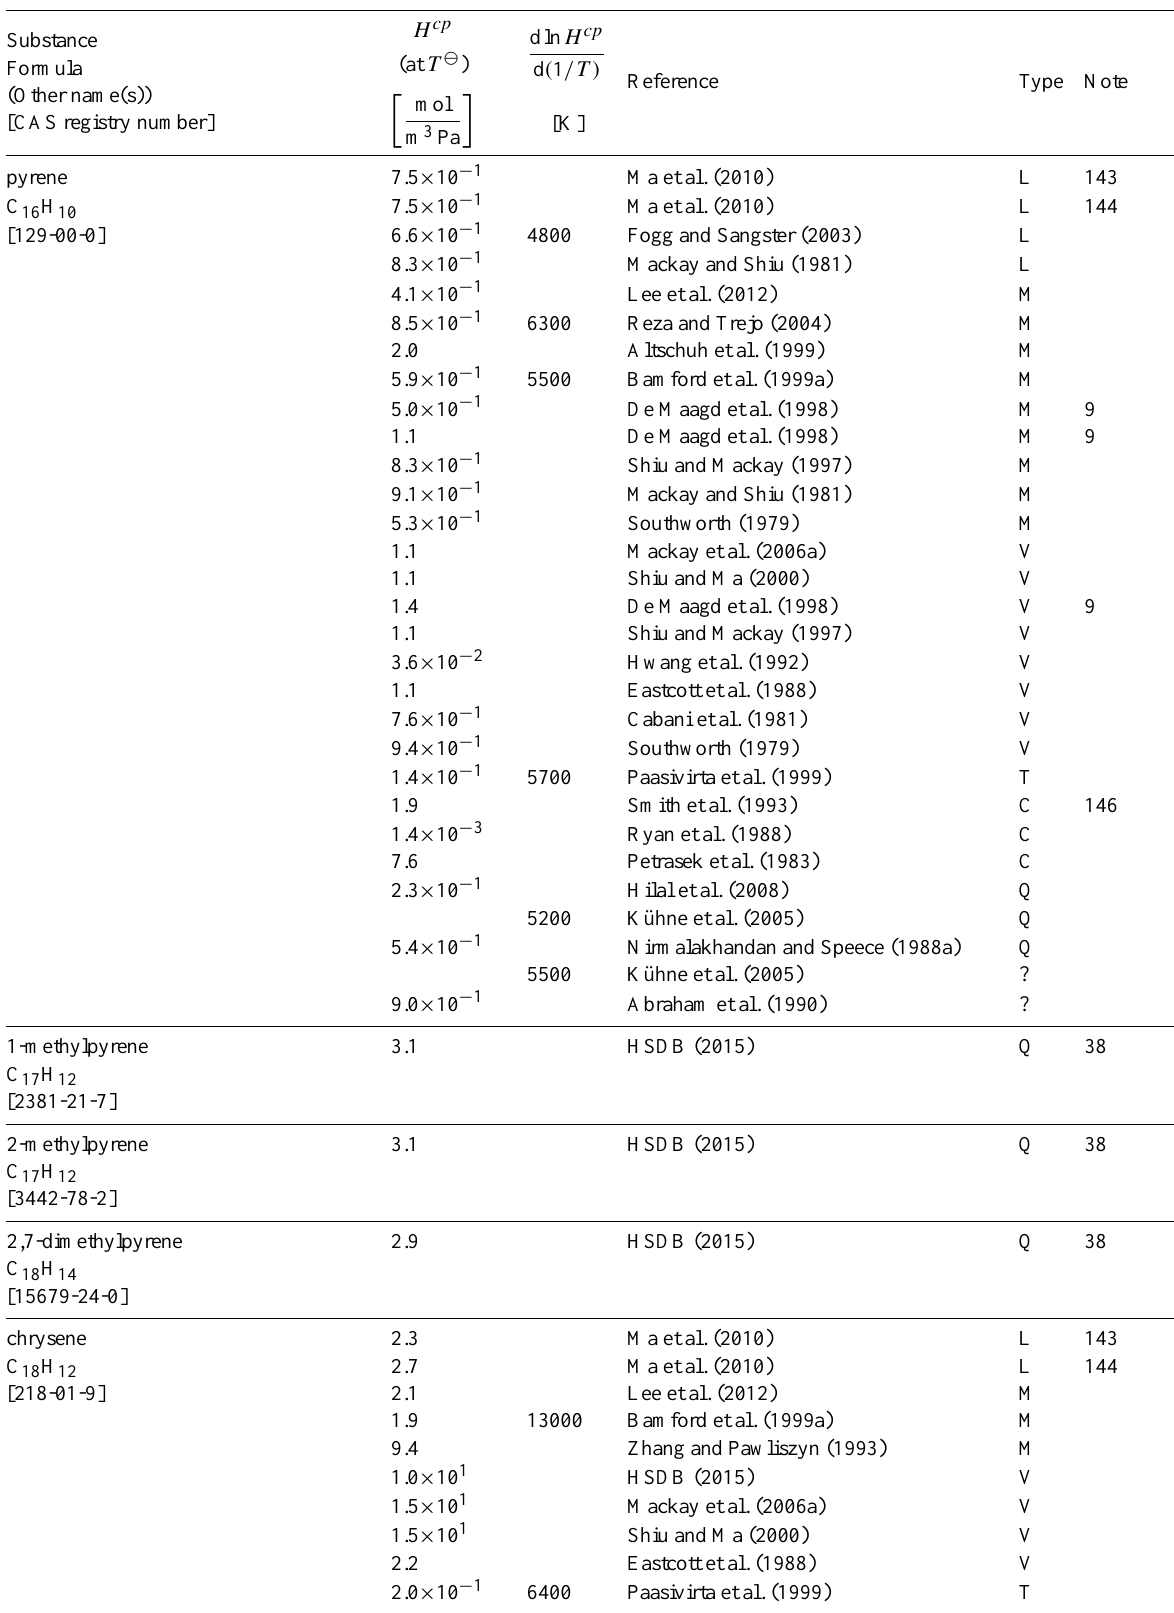
Table 6: Henry’s law constants for water as solvent